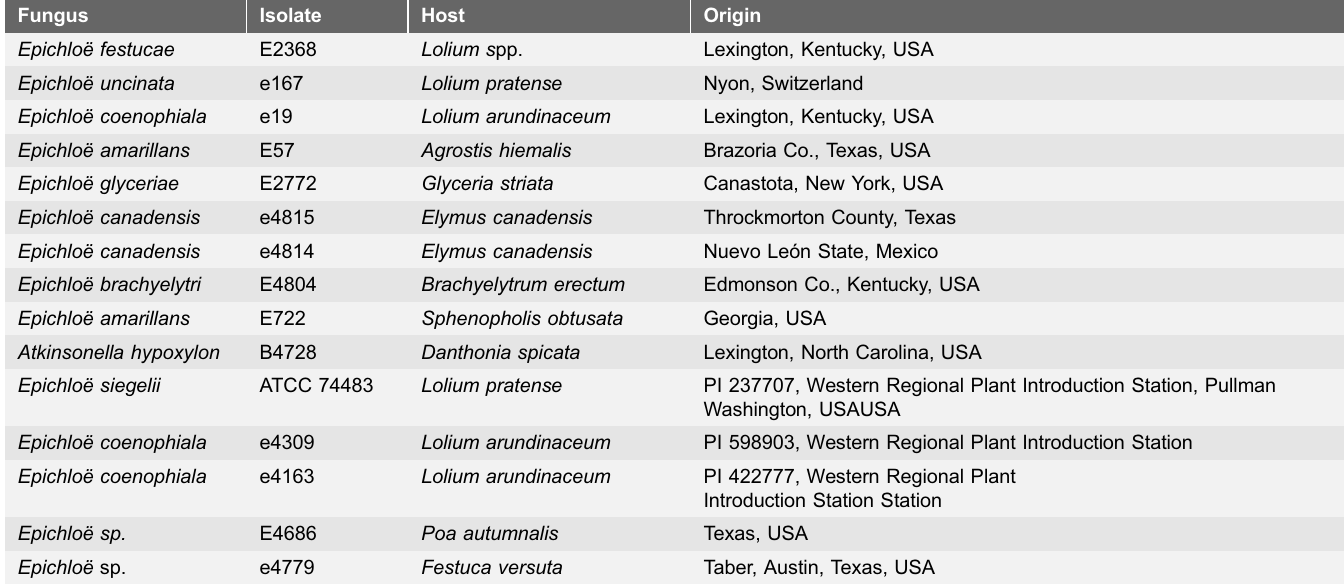
Table 1. Fungal isolates in this